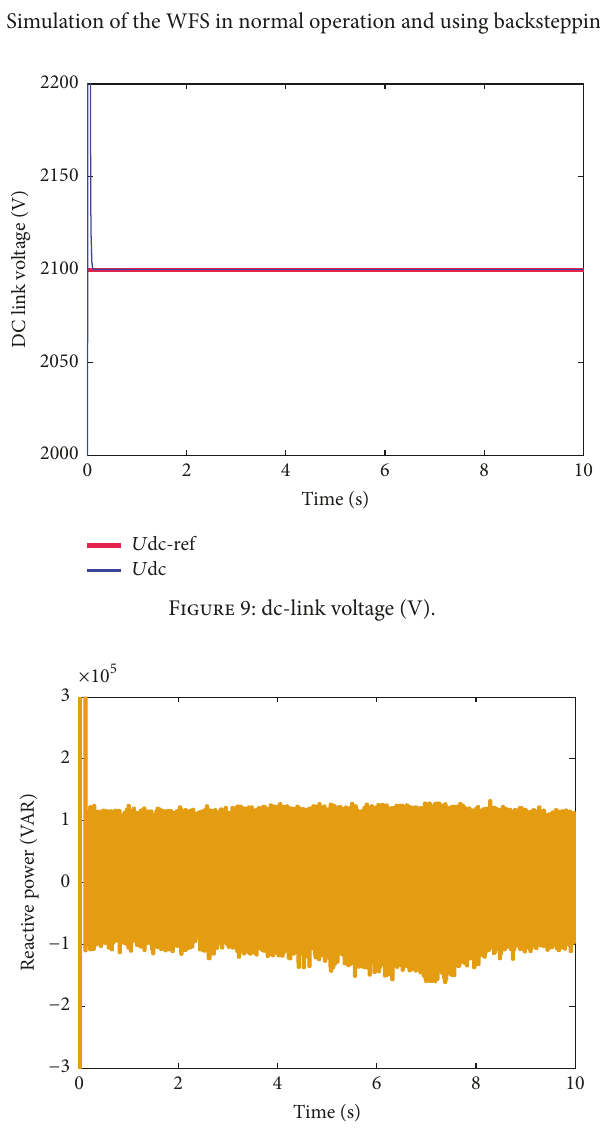
Figure 10: Reactive power